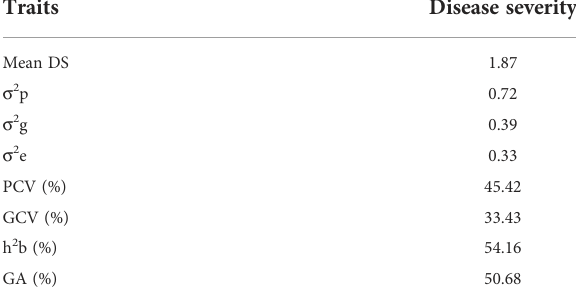
TABLE 7 Phenotypic and genetic coef fi cient of variation and heritability for blast disease severity across locations. Traits